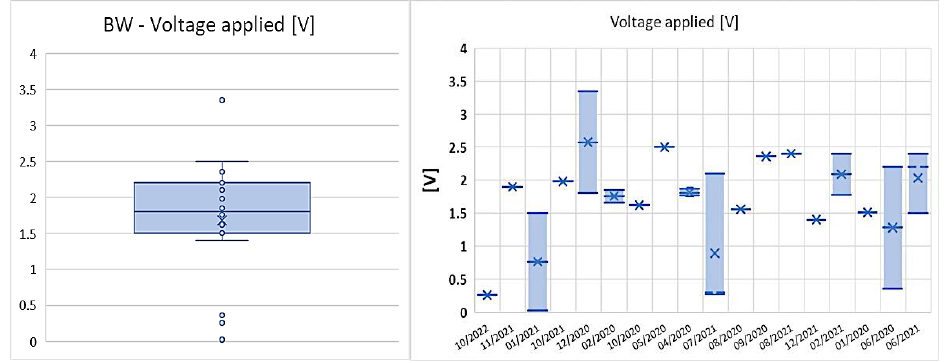
Figure 7. Graphic representation of the voltage applied [47,57,60,70,76,77,89,90,94,98,101,113,115,117,123,126,129 – 132,126,127,129 – 132,135 – 141,143,144,145]. The correlation between voltage and current density in the articles identified is 0.23883.